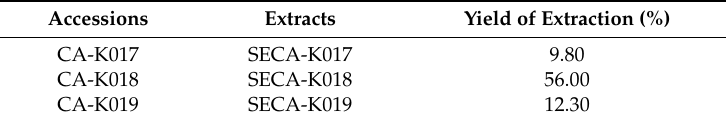
Table 2. Percentage yield of CA accessions